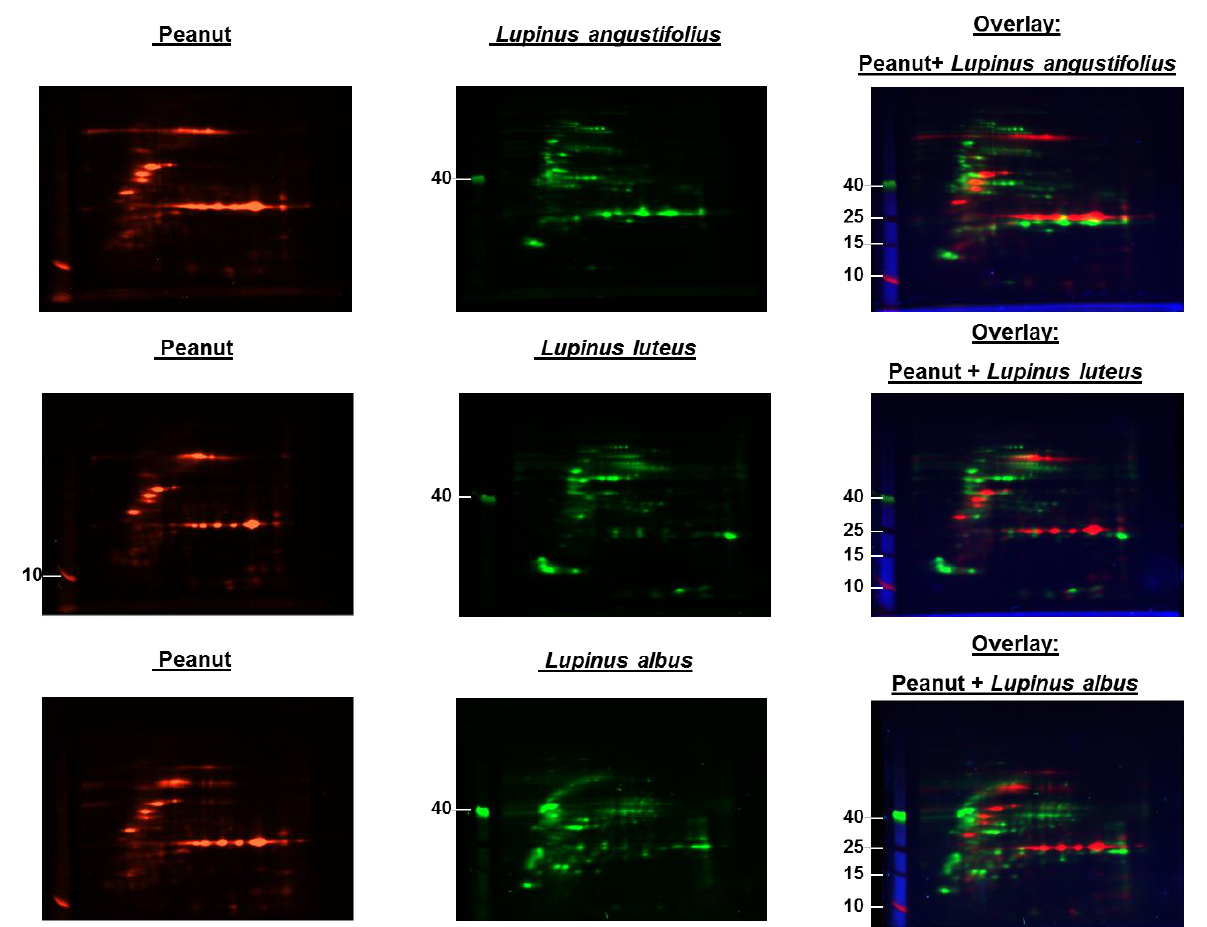
Figure 1. ( A – C ) Protein extracts obtained via alkaline extraction of flour from all three lupine species were studied by 2D-DIGE. ( A ) The control experiment shows the complete identity of the differently dyed samples of an alkaline extract of Lupinus albus by turning to yellow after having overlaid the two complementary colors, red and green. ( B ) By comparison of extracts from the three lupine species by 2D fluorescence difference gel electrophoresis (2D-DIGE), it becomes evident that there is no strong identity. On the contrary, the dominance of the single colors in the overlay speaks in favor of a broad molecular diversity of the dyed proteins in the different extracts. Whether the diversity is mirrored by immunological diversity was part of the subsequent investigations. ( C ) When comparing peanut extract with the extracts from different lupine species, there are only a few yellow areas. In addition, the differences between the lupine species become evident in this experiment as well, as there are different distributions of proteins colored green (lupine) when overlaid with peanut proteins dyed red.